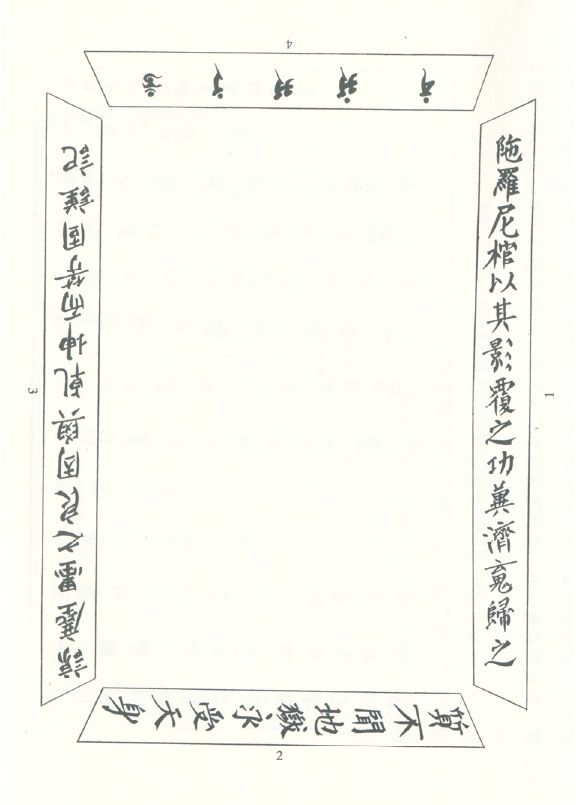
Figure 7. Drawing of the sloping sides of the lid of Zhang Wenzao’s coffin, which are inscribed with a dedicatory prayer and Siddha ṃ letters. After (Hebei sheng wenwu yanjiusuo 2001, vol. 1, p. 84, a dedicatory prayer and Siddham letters. After (Hebei sheng wenwu yanjiusuo 2001, vol. 1, p. 84, ˙ Figure 64). Figure